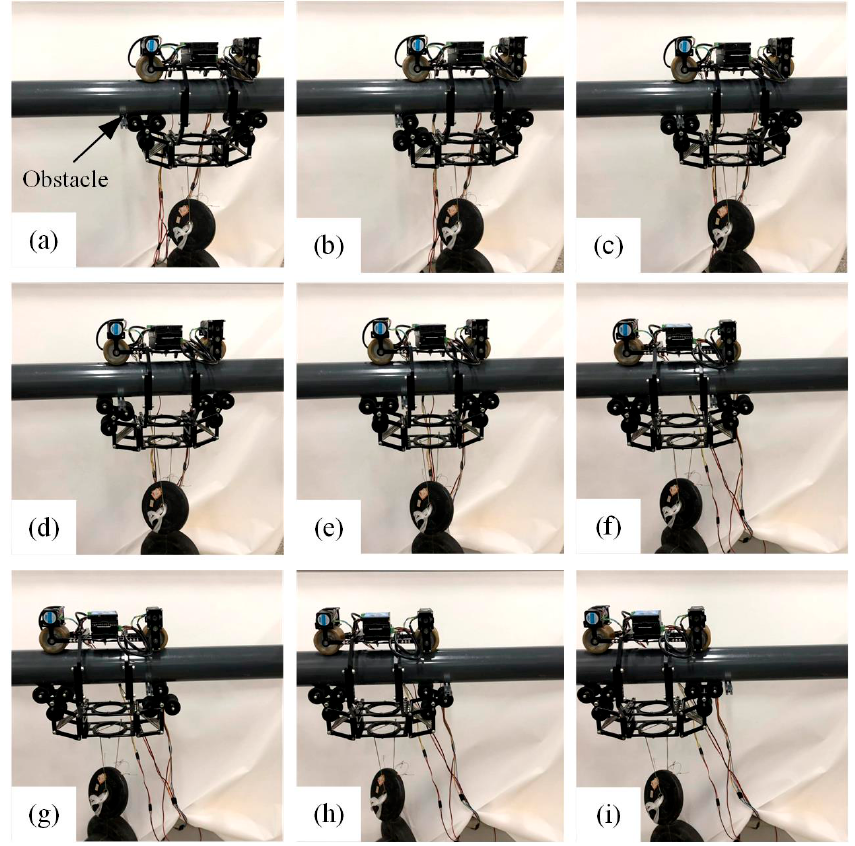
Figure 16. Obstacle-surmounting experiments: ( a – e ) Obstacle surmounting by the front composite wheel; ( f – i ) Obstacle surmounting by the rear composite wheel.